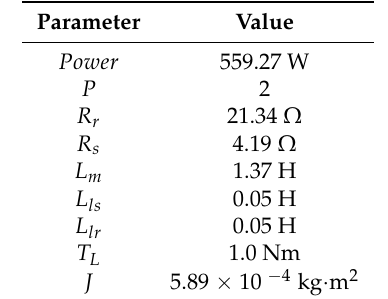
Table 2. Motor parameters used in